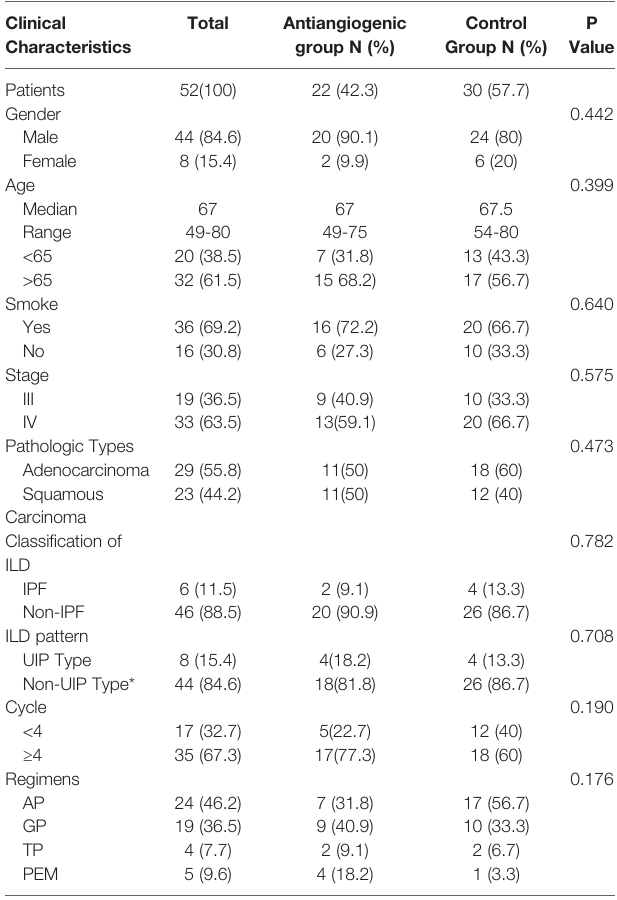
TABLE 1 | Clinical Characteristics of 52